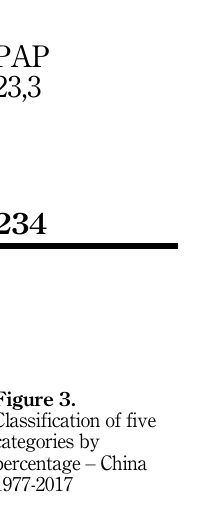
Figure 3. Classification of